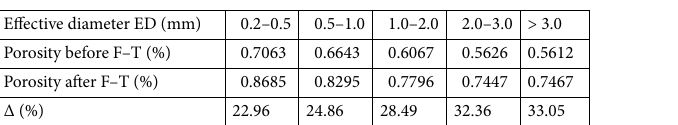
Table 2. Porosity by µCT before and after 100 F–T